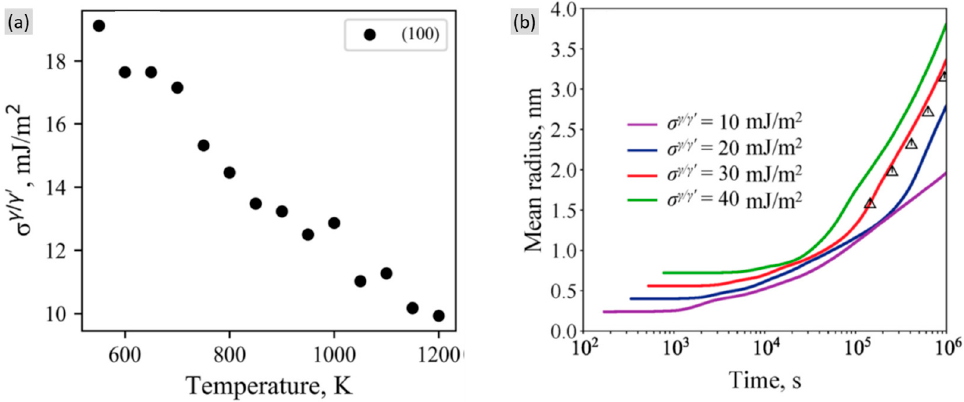
Figure 13. ( a ) Calculated interfacial energy varying with temperature and ( b ) calculated mean ra- dius versus time at 773 K by using different interfacial energy of a Ni-Al binary alloy [59]. (The triangles show the experimental data in this reference.) show the experimental data in this